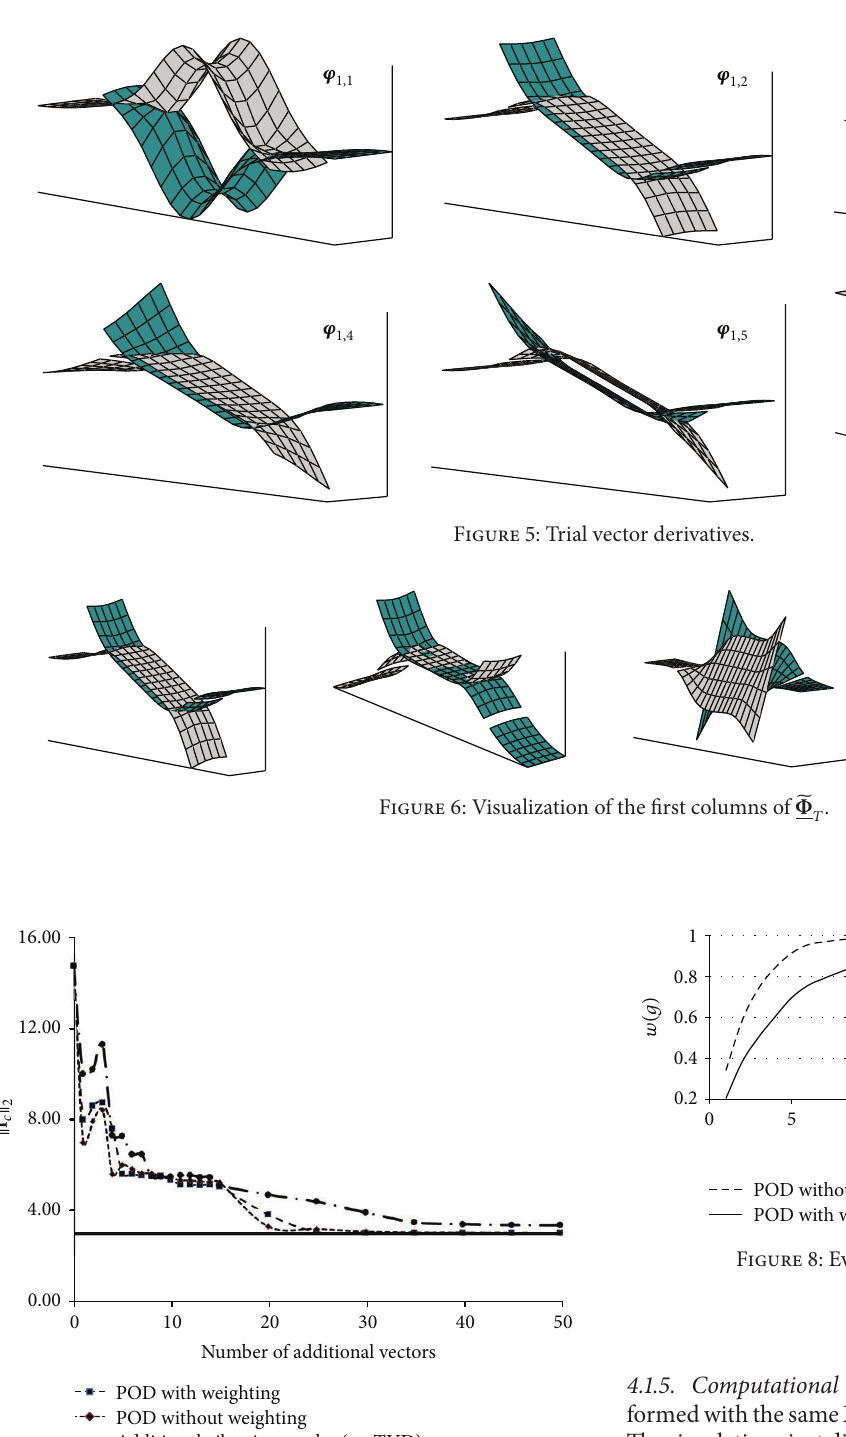
Figure 7: Convergence analysis for a static computation.